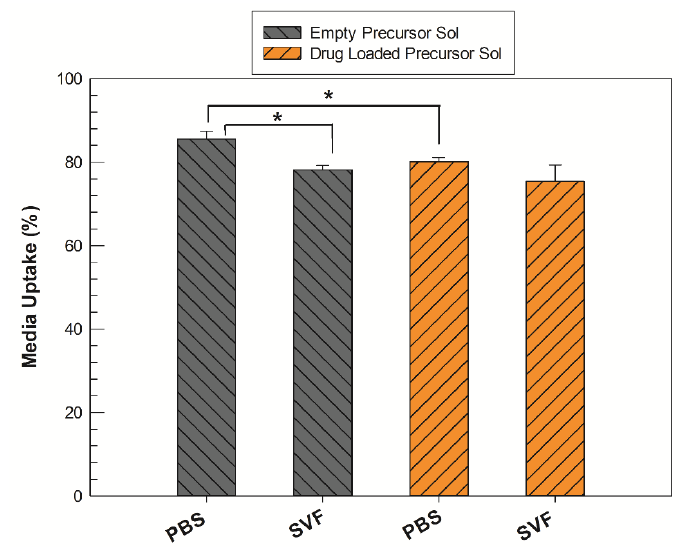
Figure 3. Medium uptake (%) of precursor solutions (Sol) in their transition to fully swollen cubic phases, both in PBS and SVF solution. The gray bars represent the empty samples, whereas the orange bars refer to drug-loaded samples. The results are expressed as mean values of three independent experiments ± standard deviation, * p < 0.05.